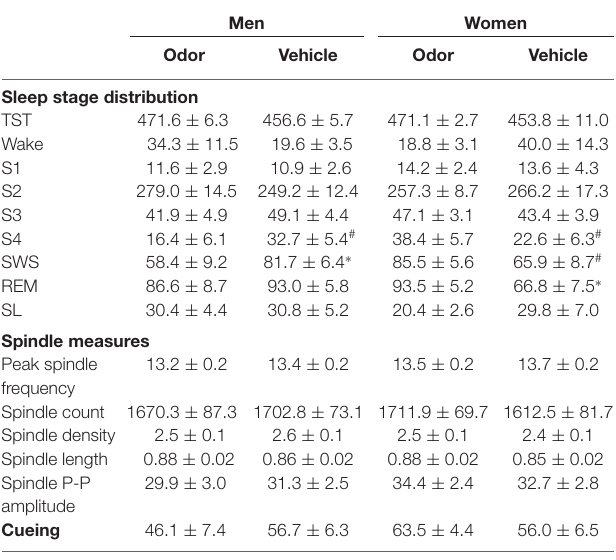
TABLE 1 | Sleep data. Men Women Odor